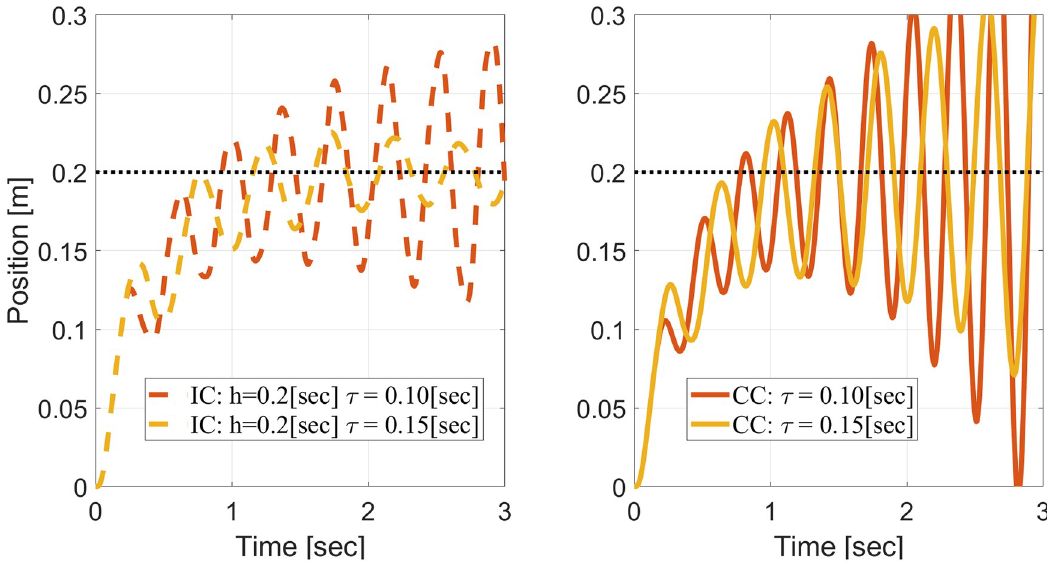
Fig 5. Simulations of reaching movements to demonstrate the stability analysis of Fig 4 for m IM = 2[Kg] and m PL = 0.4[Kg]. Left panel: periodic IC with h = 0.2[sec]. Right panel: discrete equivalent system of CC with Δ = 10 − 3 .